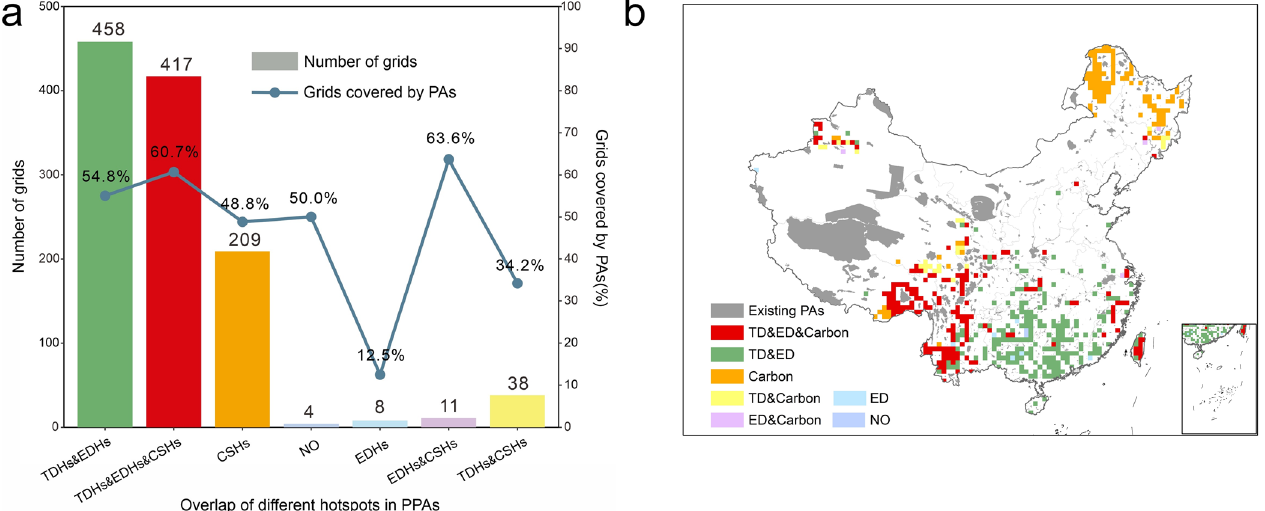
Figure 3. ( a ) The number of different overlapping types of grids for taxonomic diversity hotspots (TDHs), evolutionary diversity hotspots (EDHs) and carbon storage hotspots (CSHs) in priority protection areas (PPAs) and the proportion covered by the protected areas (PAs). The horizontal coordinate indicated the type of overlap between PPAs and TDHs, EDHs, CSHs, the bar chart indicated the number of grids in PPAs and the line chart indicated the proportion of the grids covered by PAs, ( b ) protection gap map of different biodiversity and carbon storage hotspots in PPAs in China. Areas in gray were existing protected areas.